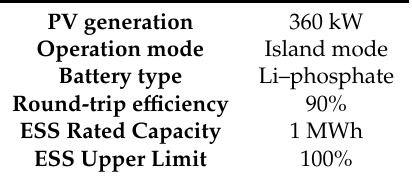
Table 2. System information on PV and energy storage system